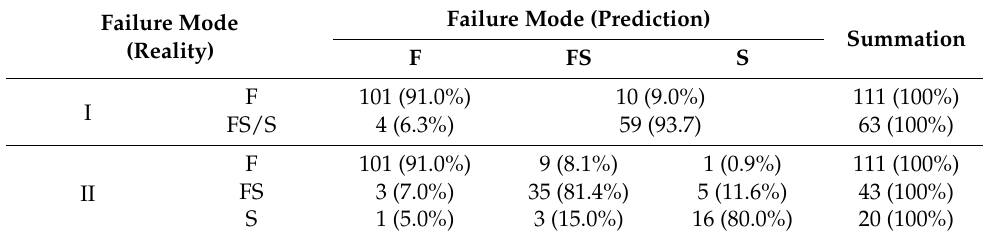
Table 3. Results of back-substitution test.